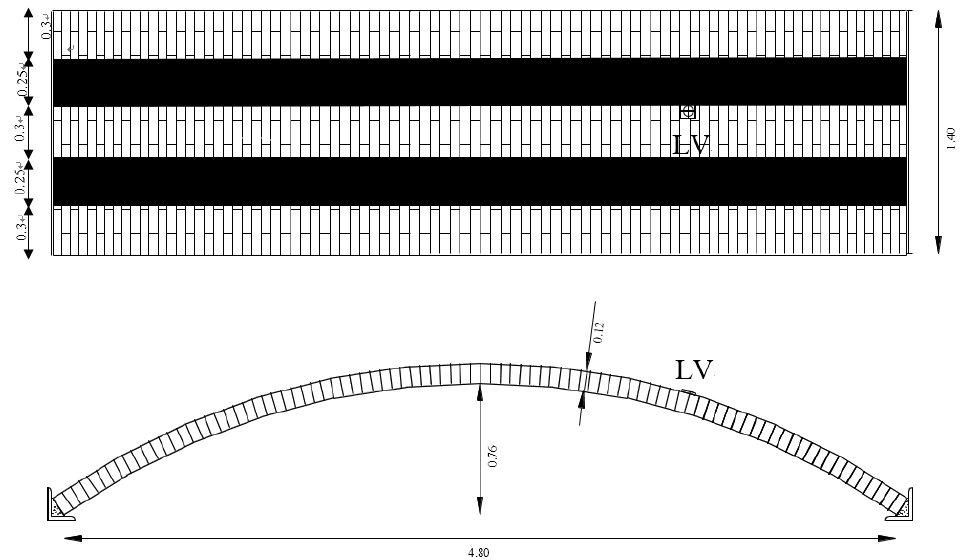
Figure 1. Configuration of the two barrel vaults (LV point is the position of the target point of the laser beam of the vibrometer) (dimensions in m).